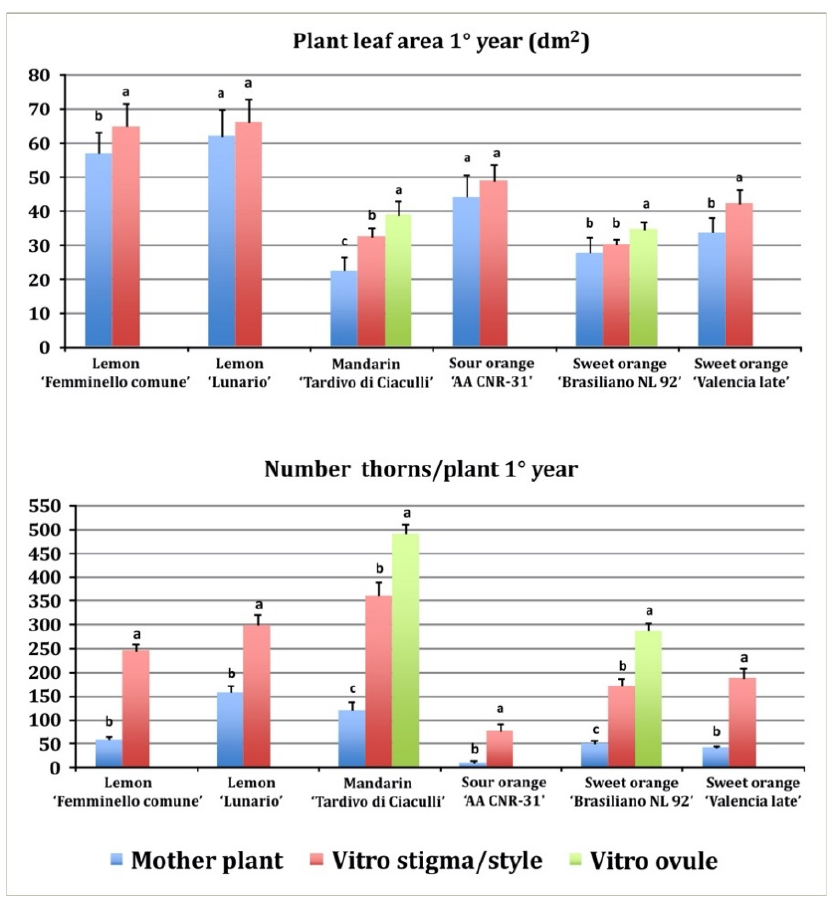
Figure 2. Plant leaf area and number of thorns per plant in the first year of growth in the field. Different letters on bars indicate significantly different values at a particular genotype according to the t -test for ‘Femminello comune’, ‘Lunario’ lemon, ‘AA CNR 31’ sour orange and ‘Valencia late’ sweet orange and according to Tukey’s multiple comparison test for ‘Tardivo di Ciaculli’ mandarin and ‘Brasilian NL92’ sweet orange. Tests were performed at p < 0.05 significance level. Bars indicate standard